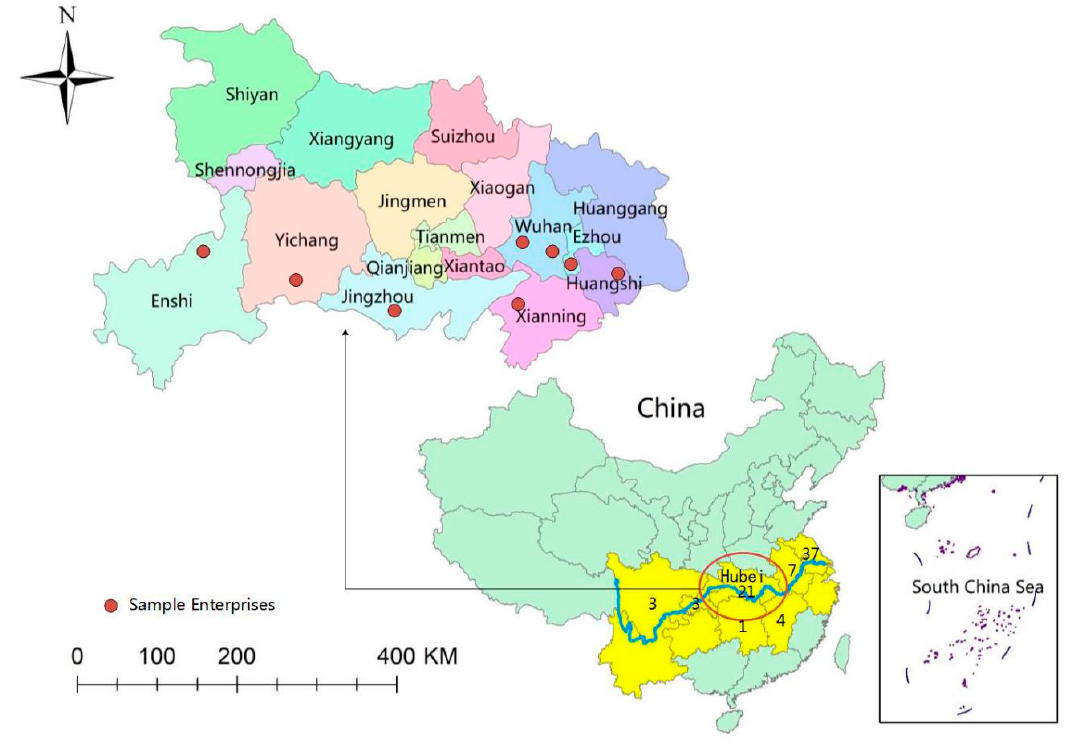
Figure 2. Locations of sample cities and enterprises.